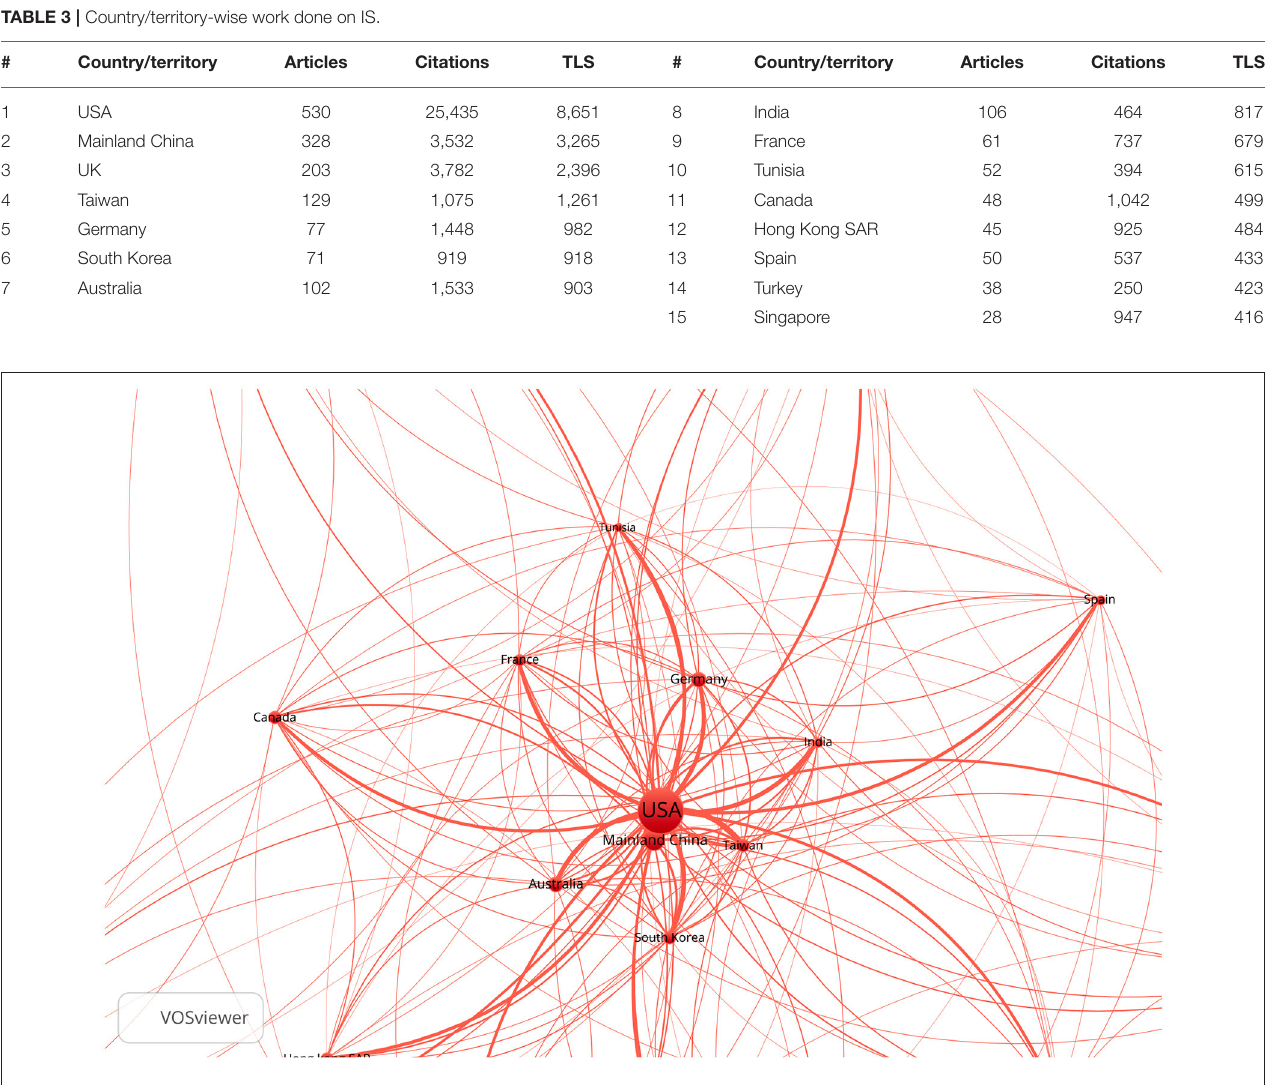
the relationship of sentiment on the stock returns (Chakraborty and Subramaniam, 2020). Schmeling (2009) uses Consumer Confidence Index as a proxy for IS and shows that